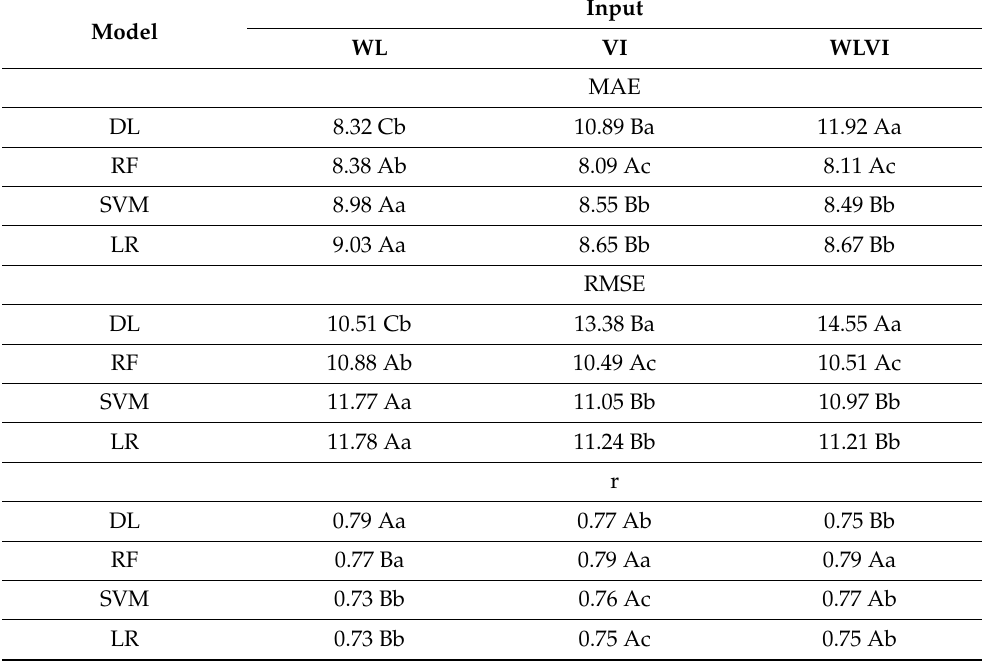
Table 3. Grouping of means of mean absolute error (MAE), root mean squared error (RMSE), and Pearson’s correlation coefficient (r) between estimated and observed values for plant height in soybean obtained with different machine learning models and input configurations.